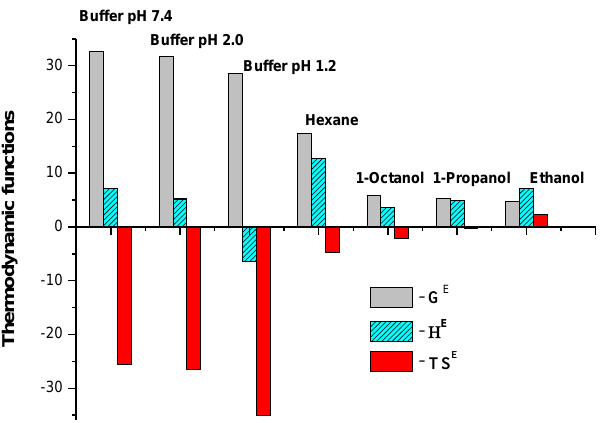
Figure 9. Excess thermodynamic solubility functions of IVZ in the investigated solvents.